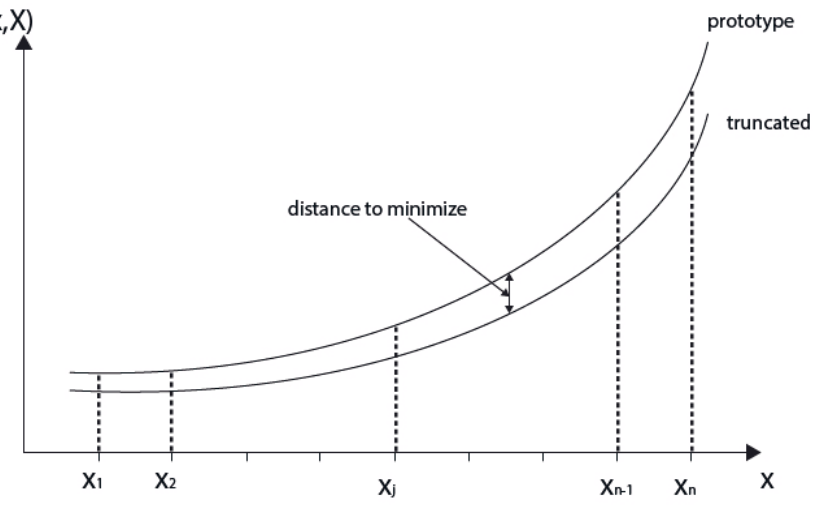
Figure 8. Prototype vs. truncated mooring system